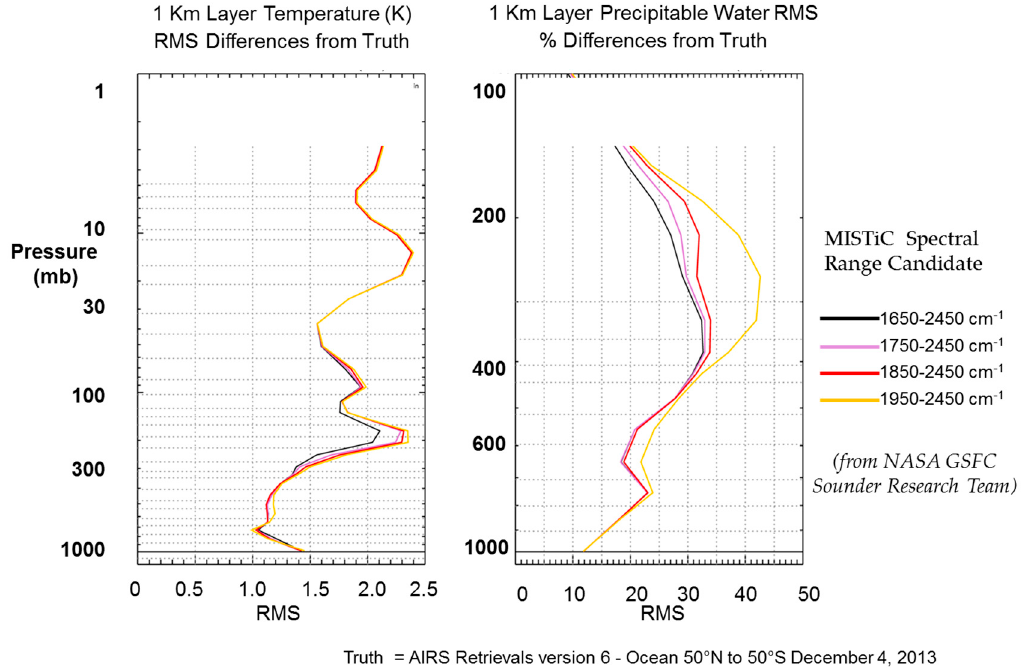
Figure 5. A spectral range trade study using atmospheric infrared sounder (AIRS) Version 6 retrievals for a diverse set of cloud-clear footprints over the Pacific showed that a lower spectral range cutoff of 1750 cm − 1 provided a good vertical coverage with needed accuracy for tropospheric temperature and water vapor.